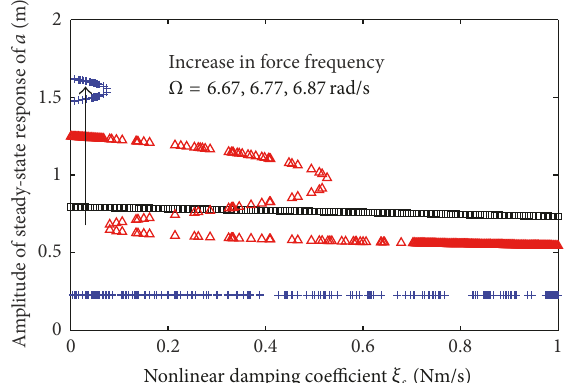
Figure 6: The effect of varying force frequency Ω on nonlinear damping coefficient response of vibration 𝑎 . Ω = 6.67 rad / s ( black squares), Ω = 6.77 rad / s (red triangles), and Ω = 6.87 rad / s (blue crosses).